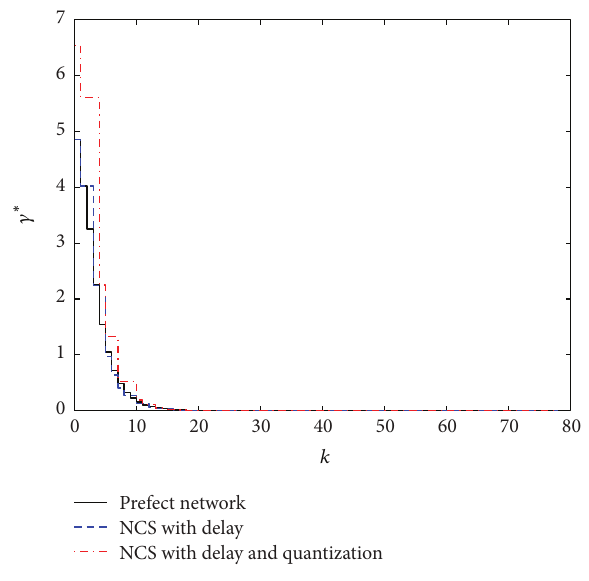
Figure 16: The evolution of 𝛾 ∗ (Example 2).